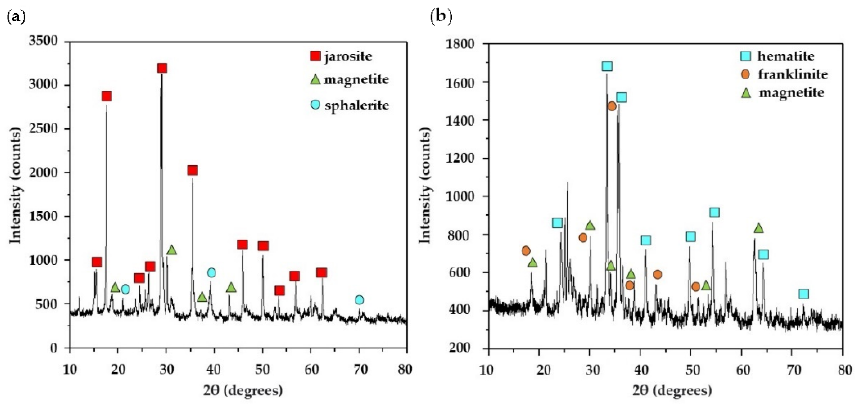
Figure 2. Diffraction patterns of samples of ( a ) JST and ( b ) JTT.